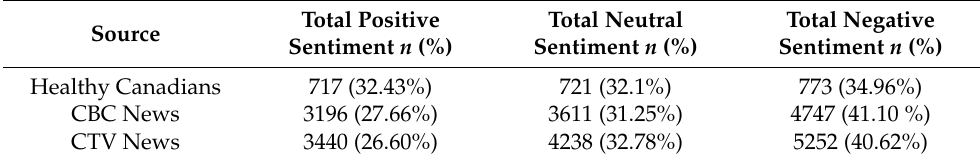
Table 6. Summary of sentiment for Healthy Canadians, CBC News, and CTV News.